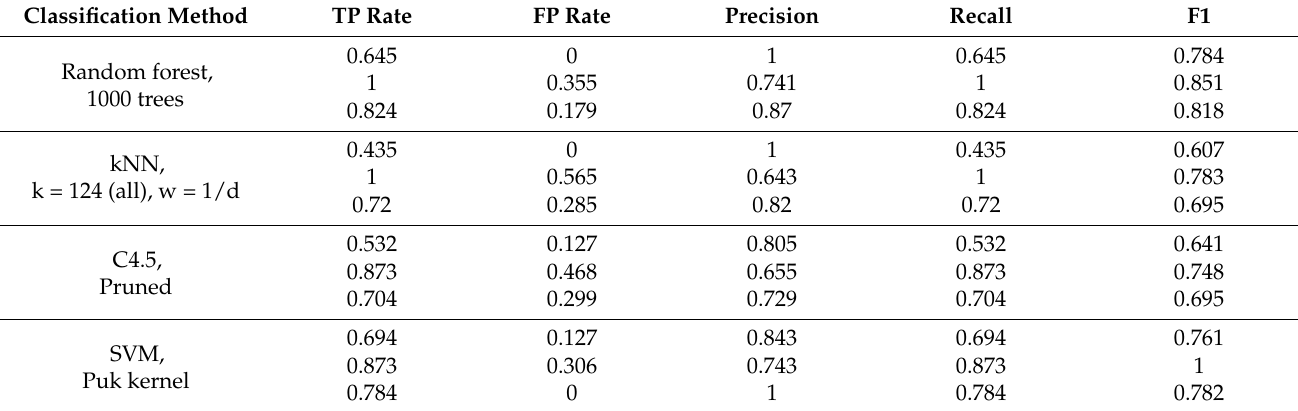
Table 10. Precision and recall analysis for the augmented dataset.